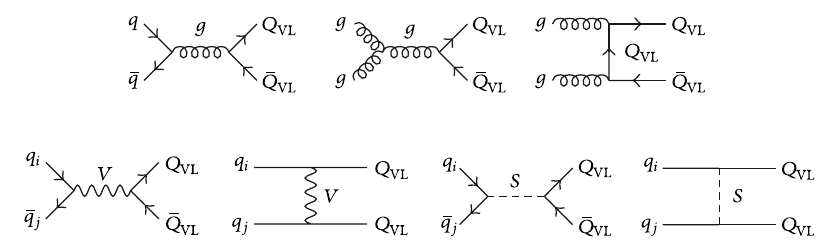
Figure 5: Feynman diagrams for pair production of a generic VLQ. Above the dominant and model-independent QCD contributions, below the subdominant and model-dependent EW contributions. Arrows on fermion lines have been removed to account for both particles and antiparticles, when necessary. Notice the possibility to have FCNCs between SM quarks in the 𝑉 and 𝑆 s-channel diagram, which is peculiar to VL scenarios.